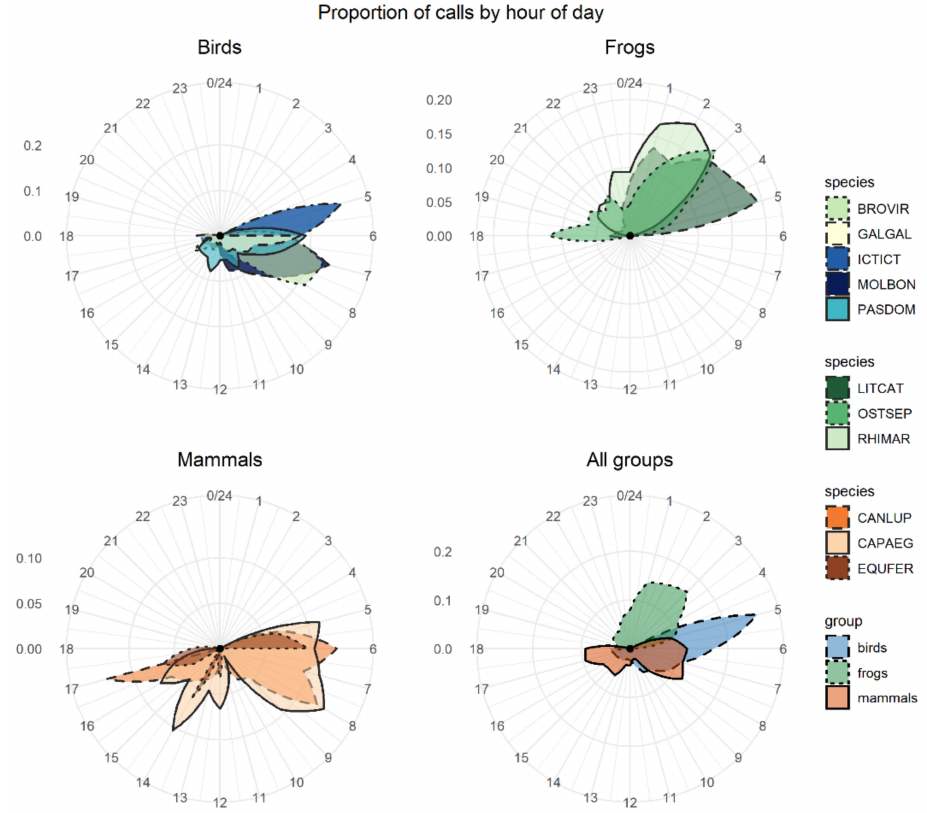
Figure 2. Polar plot representing the frequency of call activity of eleven invasive alien species across Puerto Rico from March to June 2021. The numbers around the polar plots are hours of day and the numbers to the left of the panel represent the gray rings in the plot, which are frequency of call activity. Top left: calling activity patterns of bird species (we used only the three birds with the highest number of detections because they represented 91% of bird detections). Top right: calling activity patterns of frog species. Bottom left: calling activity patterns of mammal species. Bottom right: Calling activity patterns by group. We used the three first letters of the genus and a specific epithet for species in the legends (e.g., Gallus gallus domesticus = GALGAL). We emphasize that the polar plots for birds and mammals were biased to the diurnal period while that for frogs was biased to the nocturnal